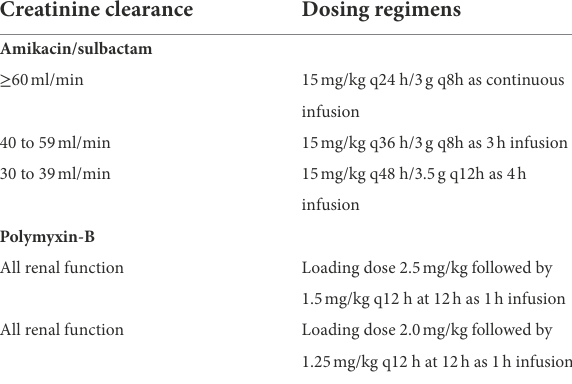
TABLE 1 Dosing regimens of amikacin/polymyxin-B/sulbactam used in simulation by creatinine clearance category. Creatinine